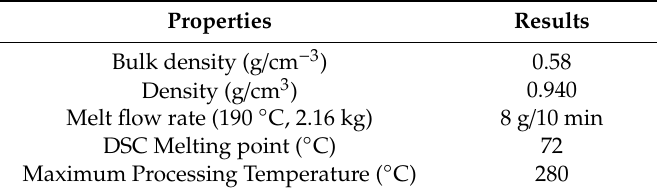
Table 2. Properties and processing information of RET.